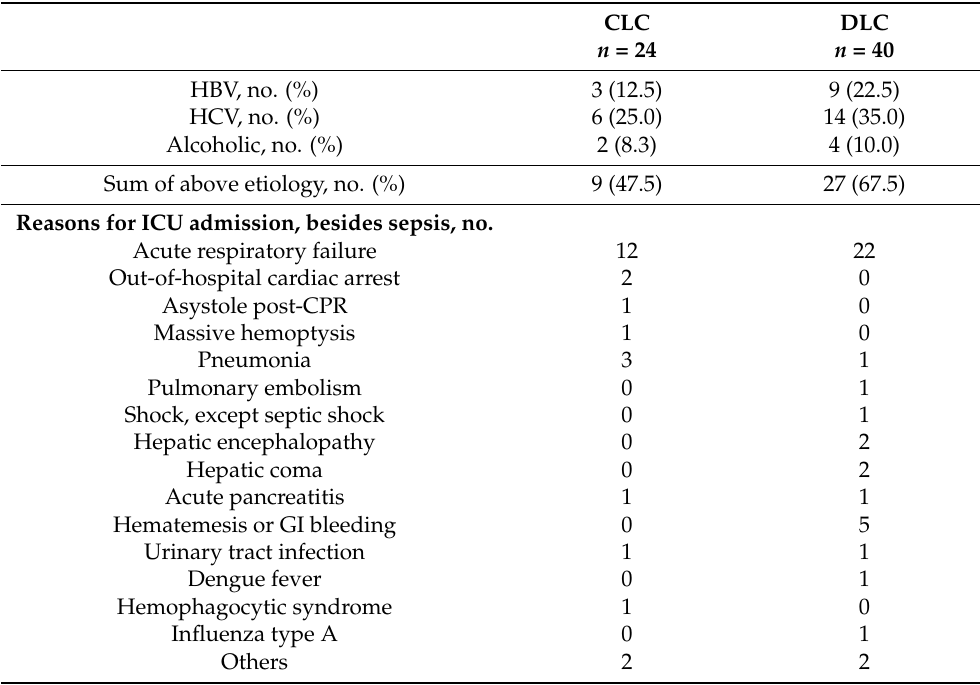
Table 3. Patient characteristics between the compensated liver cirrhosis group and the decompensated liver cirrhosis group.